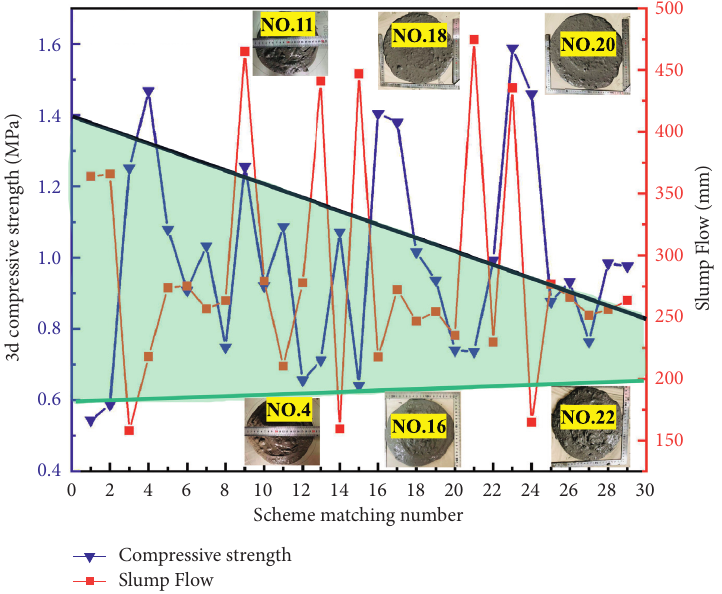
Figure 7: Interaction diagram of compressive strength and expansion at different ages under different proportion numbers. Table 3: Optimization of and expansion under different compressive